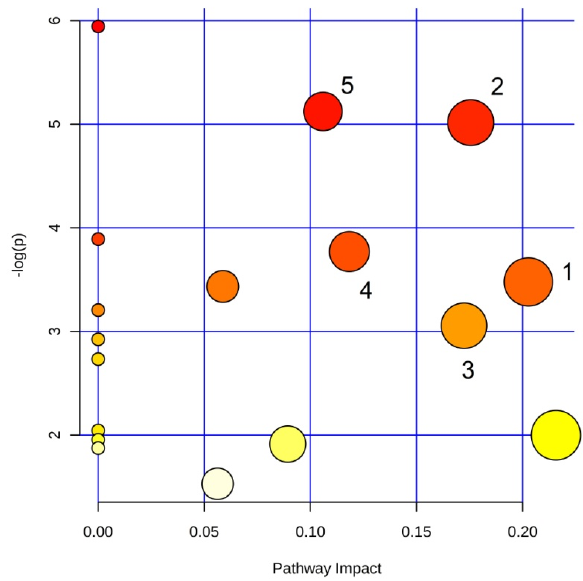
Figure 4. Pathway analysis based on most relevant metabolites identified by OPLS-DA. Pathways are identified as follows: 1, glycine, serine and threonine metabolism; 2, arginine biosynthesis; 3, glutamate and glutamine metabolism; 4, arginine and proline metabolism; 5, glutathione metabolism.